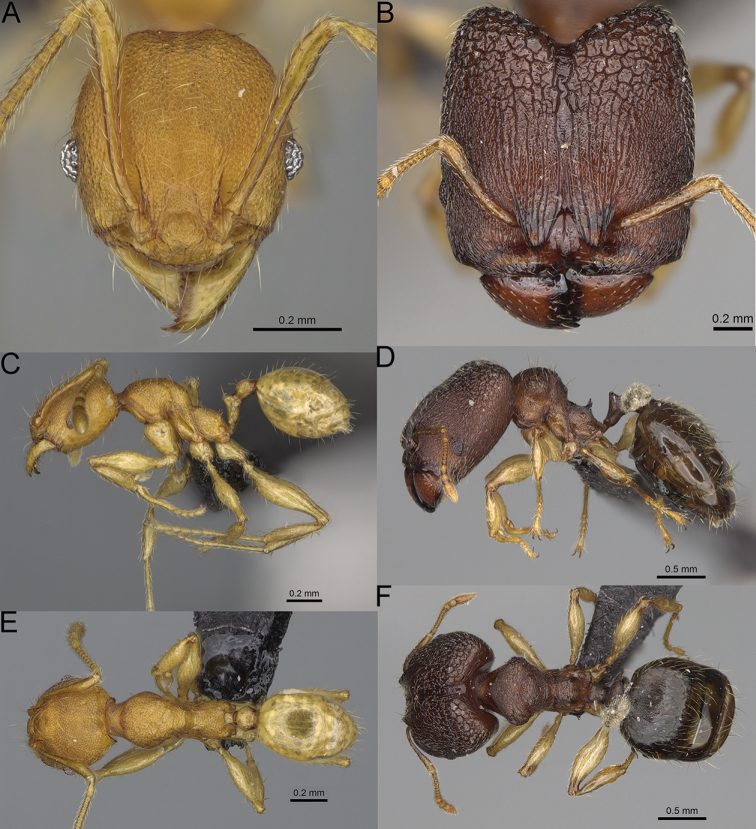
Pheidole
petax Forel, full-face view (A), profile (C), and dorsal view (E) of minor worker (CASENT0455969) and full-face view (B), profile (D), and dorsal view (F) of major worker (CASENT0119429).